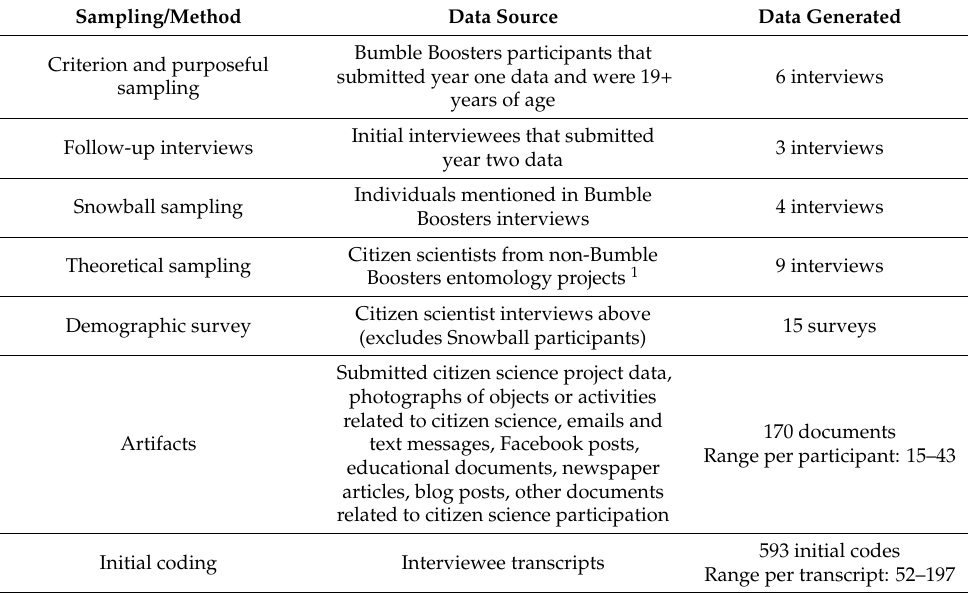
Table 2. Sampling types, methods and data sources utilized to generate